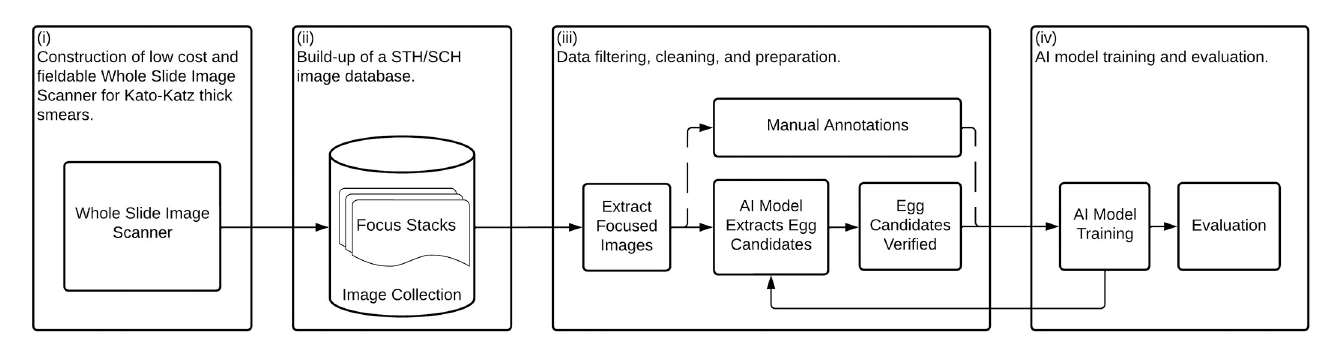
Fig 1. The process used to explore the feasibility of an artificial-intelligence-based-digital-pathology device.